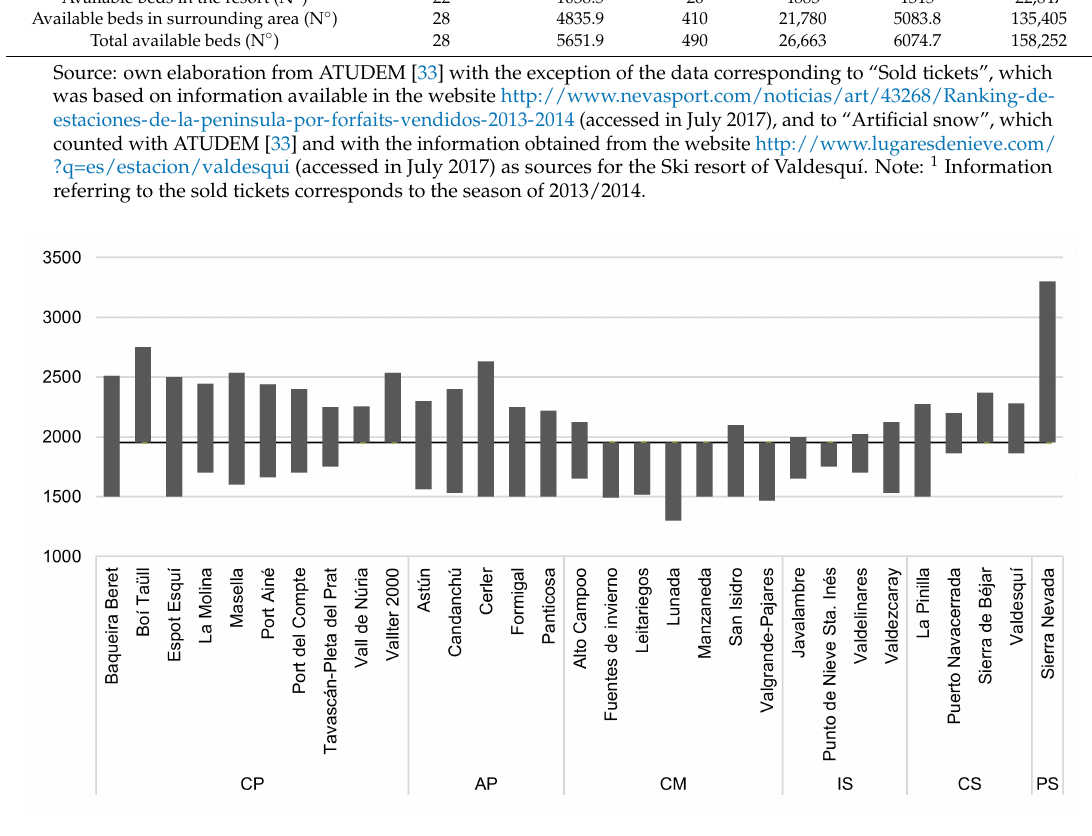
Figure 2. Elevation range of alpine ski resorts of Spain (meters). Source: ATUDEM [33]. The abbreviations stand for: CP (Catalan Pyrenees); AP (Aragonese Pyrenees); CM (Cantabrian Mountains); IS (Iberian System); CS (Central System); and PS (Penibaetic System). The horizontal line corresponds to the average altitude of 1953.3